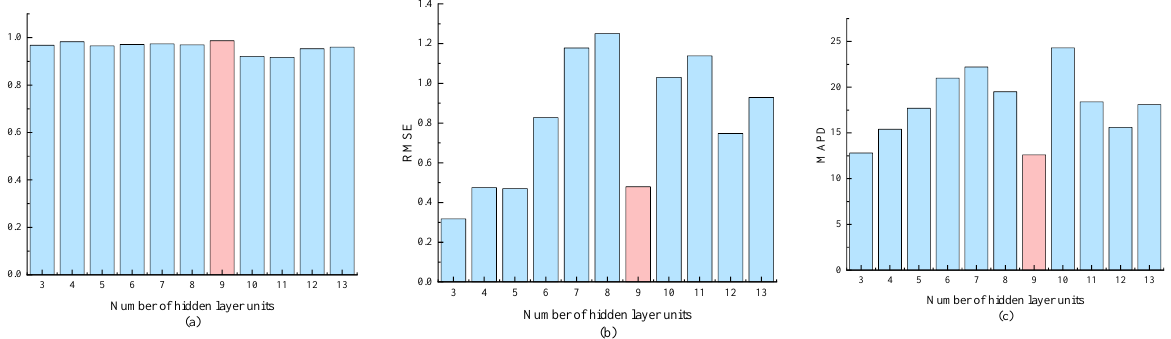
Figure 2. Statistical indicators with different numbers of hidden-layer units in BPNN: ( a ) R 2 ; ( b ) RMSE ; ( c ) MAPD . The red part represents the hidden layer unit eventually adopted, and the blue part represents other units within the range.